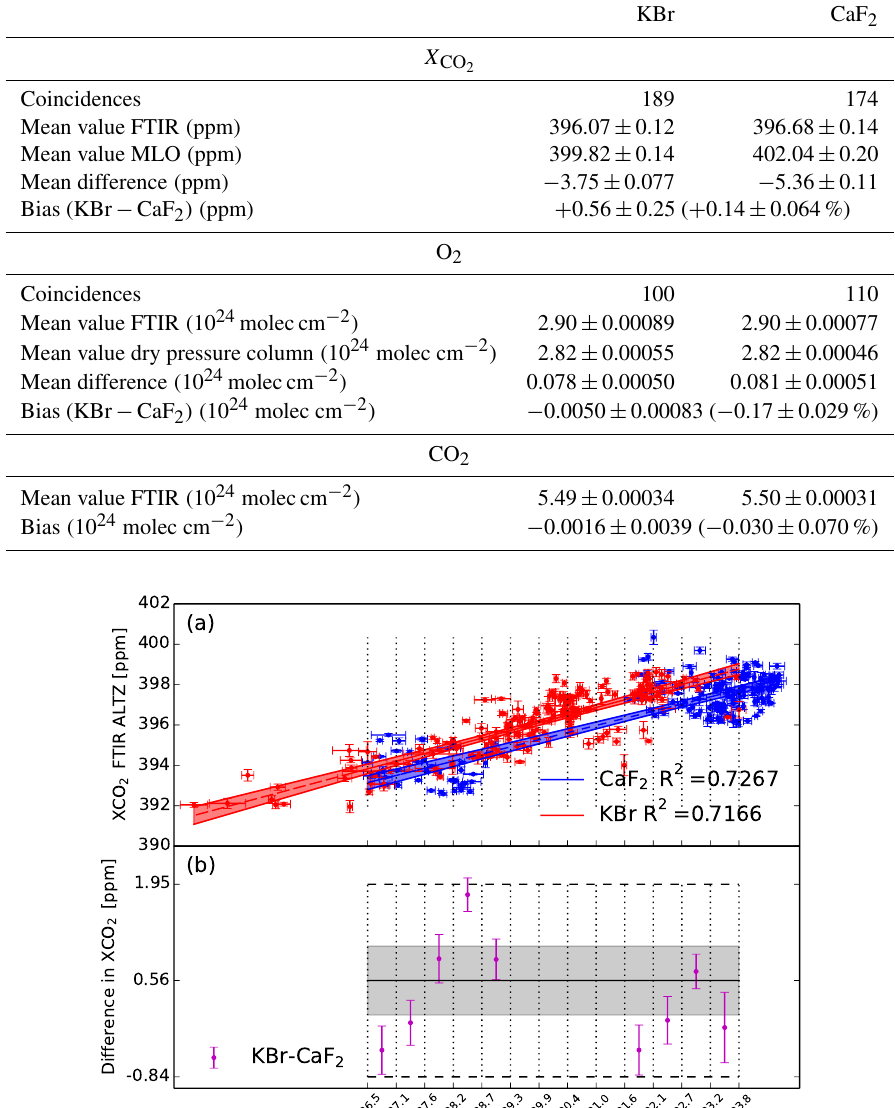
Table 6. Mean values of X CO , CO 2 and O 2 and the bias obtained for each of them using the beam splitter ensembles. For X CO 2 Loa Observatory (MLO) was used, and for O 2 the dry pressure column was calculated and multiplied by 0.2095. The bias of CO 2 was obtained from Eq. (4).